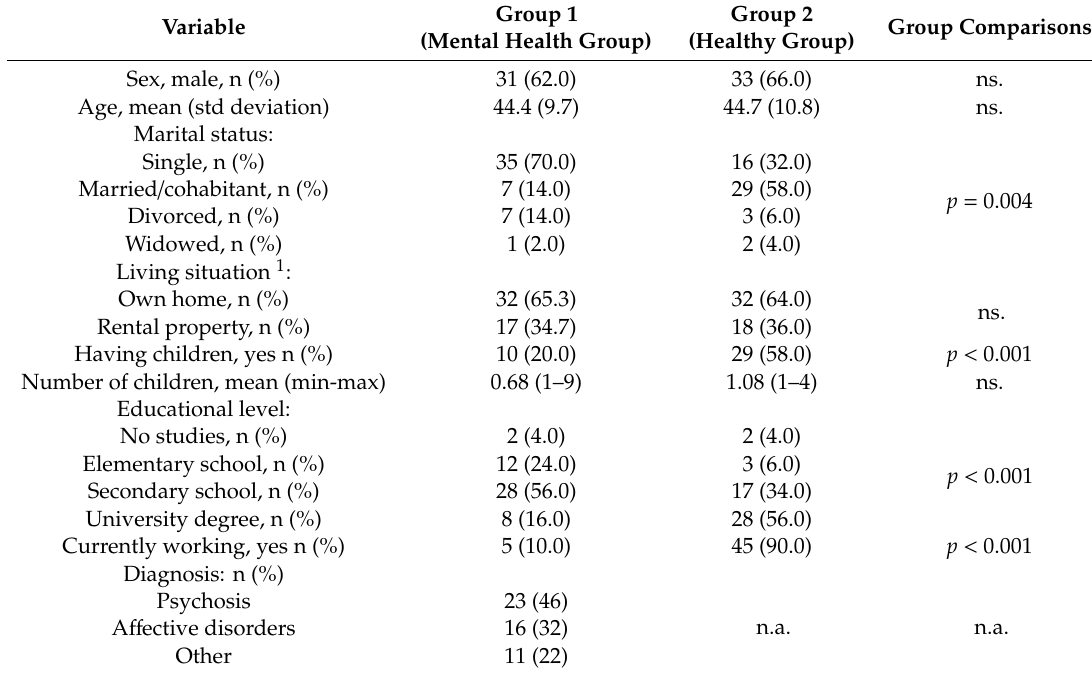
Table 1. Socio-demographics and clinical characteristics of the